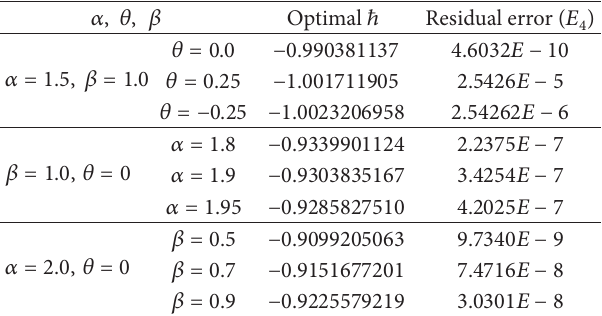
Table 1: The estimated optimal convergence parameter ℏ and the corresponding residual error 𝐸 𝑚 at different fractional parameters used in Example 11.